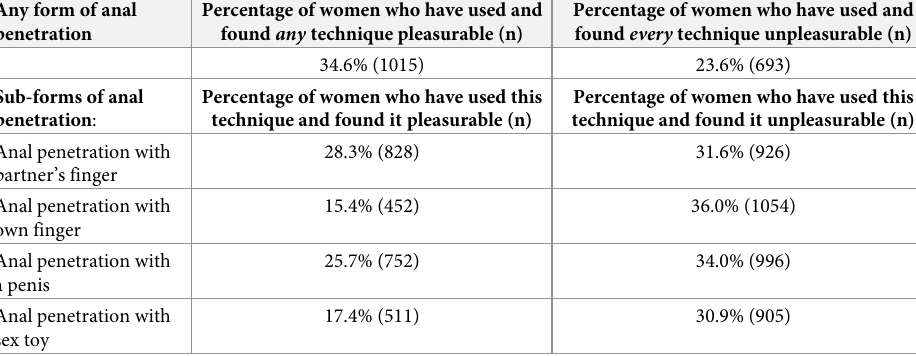
Table 3. Prevalence of anal penetration (either shallow or deeper) techniques women find pleasurable (N = 2931, weighted). Any form of anal Percentage of women who have used and penetration found any technique pleasurable